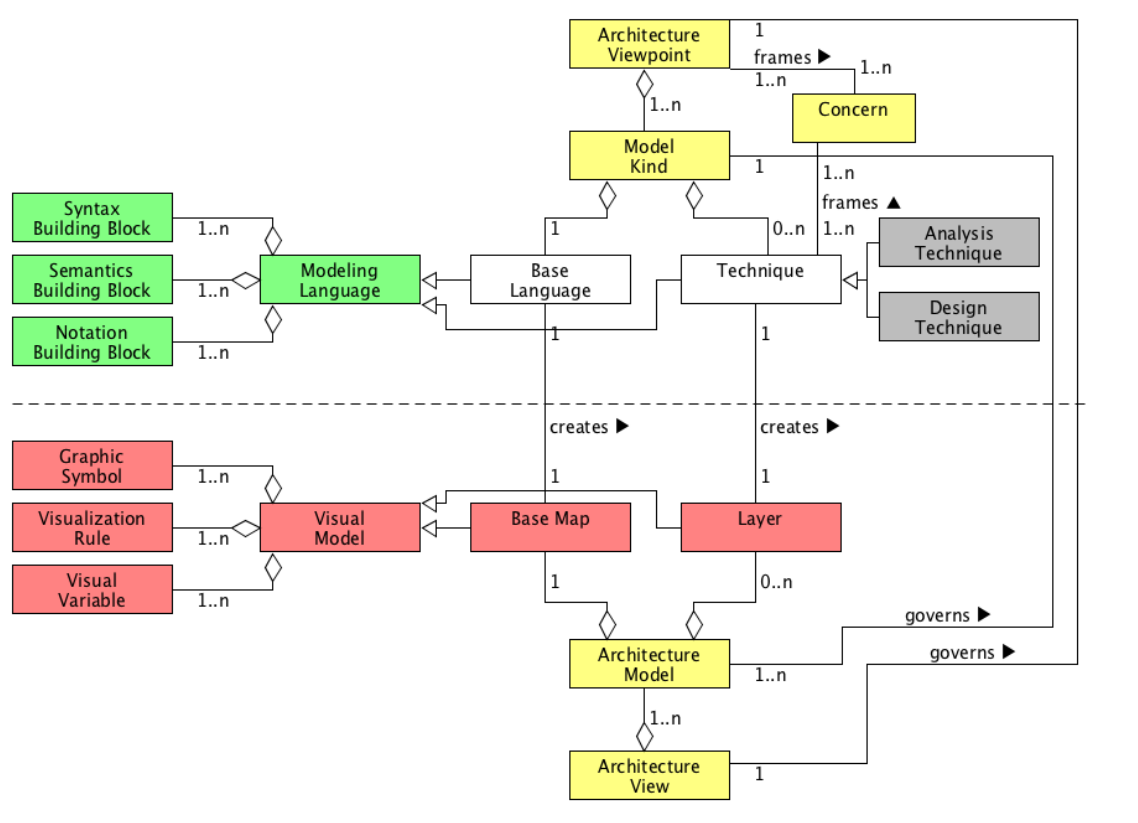
Figure 5. Integration of Architecture Viewpoint and